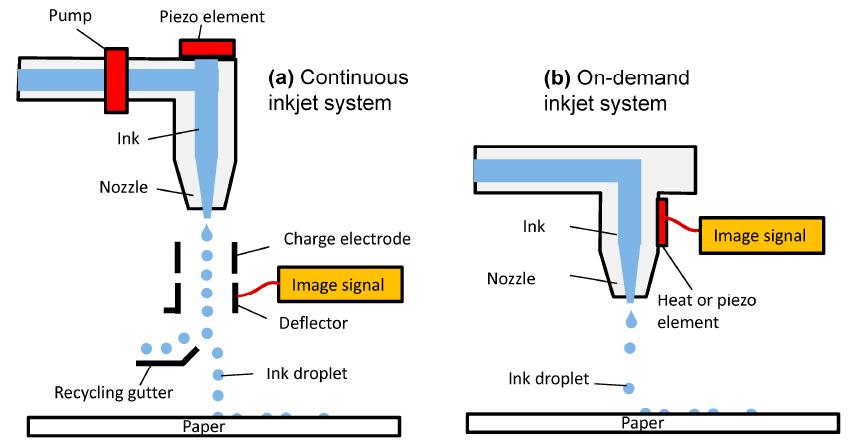
Figure 5. Simplified representation of two different categories of inkjet printing mechanism: ( a ) con- tinuous inkjet printing (CIJ) and ( b ) drop-on-demand printing (DOD)[81].